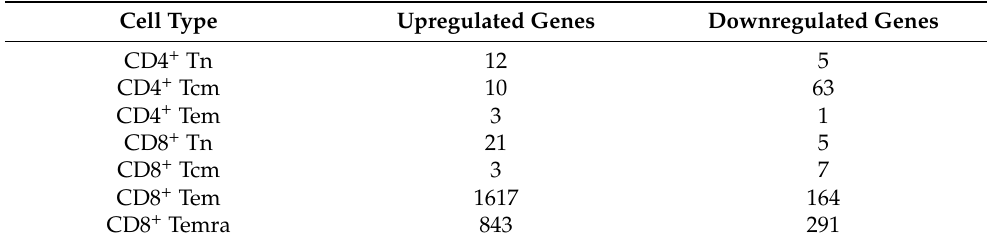
Table 2. Upregulated and downregulated genes of untreated RA compared with healthy samples of T cell subsets.